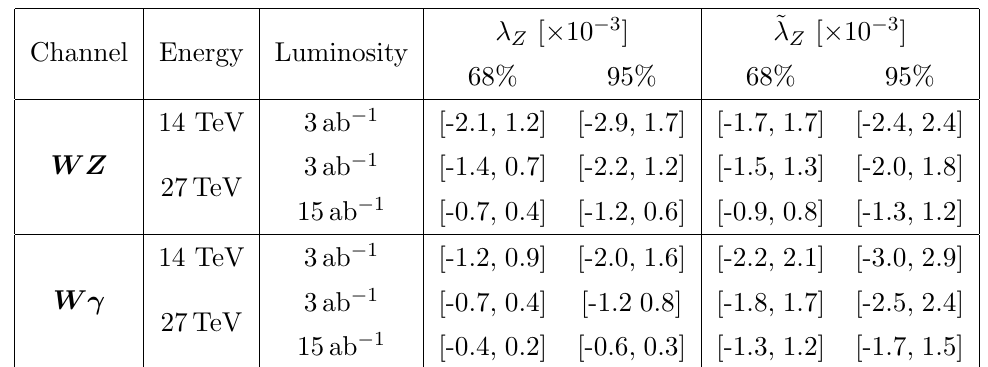
Table 2 . Summary of the results for the various channels in terms of the CP-even and CP-odd anomalous triple gauge couplings. Only events with m T